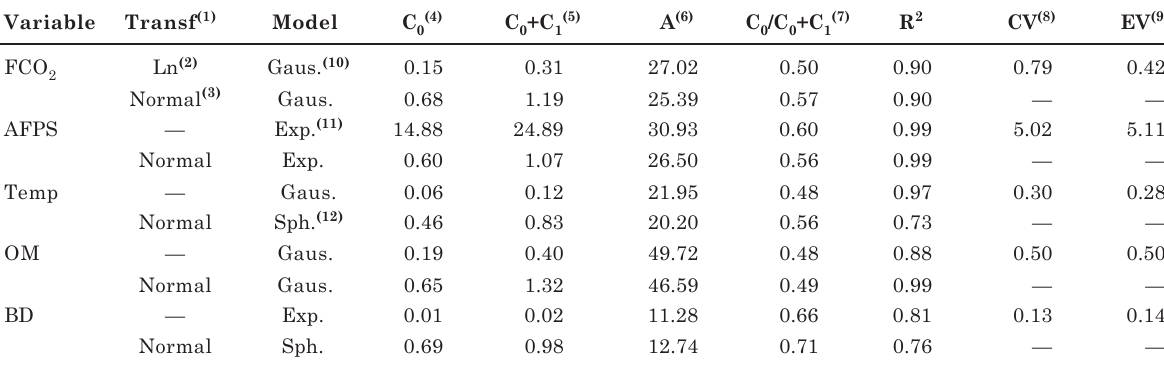
Table 2. Type of transformation used and parameters of models fitted to experimental variograms of soil CO 2 emissions (FCO 2 ), air-filled pore space (AFPS), soil temperature (Temp), organic matter content (OM) and soil bulk density